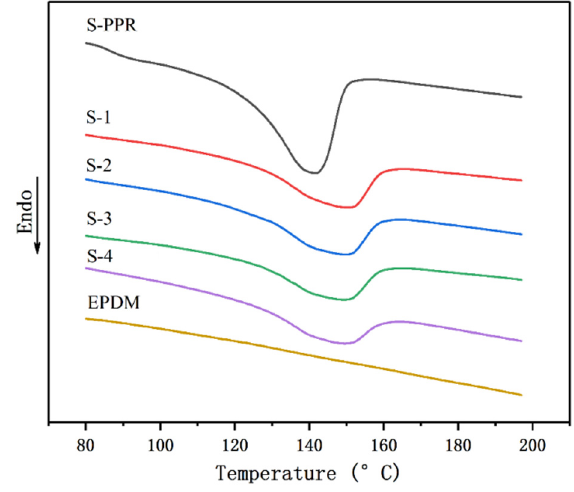
Figure 7. DSC curves of various materials.